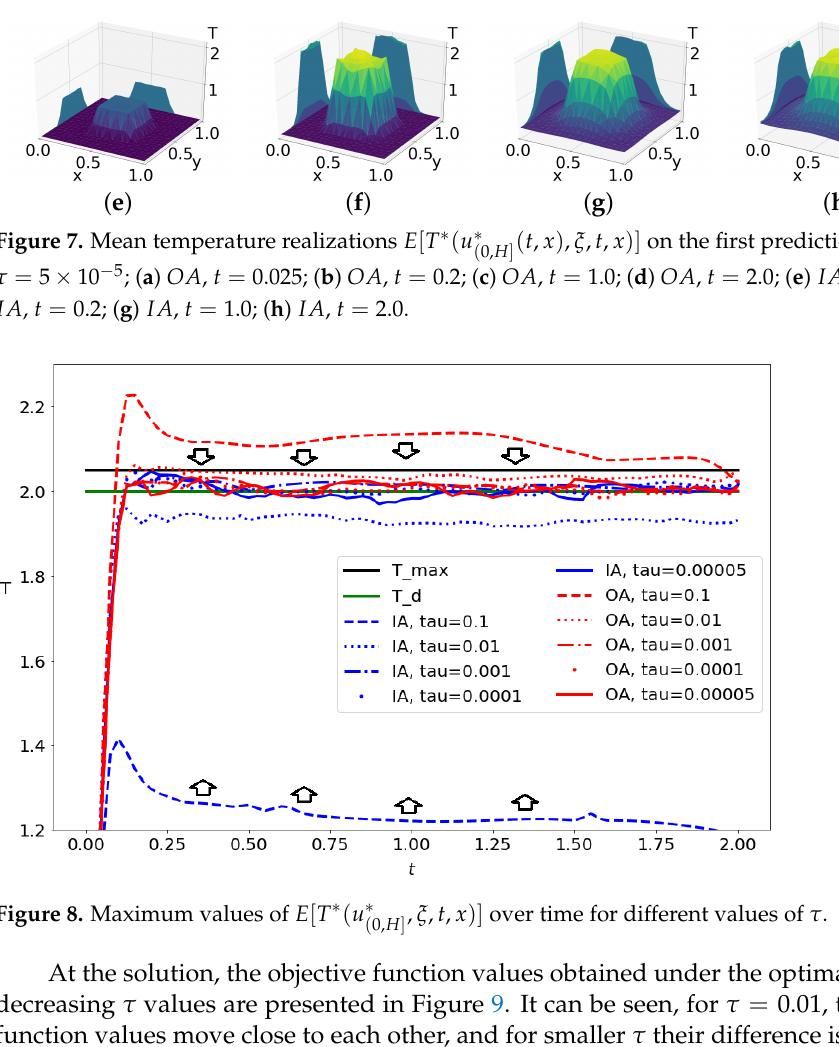
, ξ , t , x )] over time for different values of τ ( 0, H ]